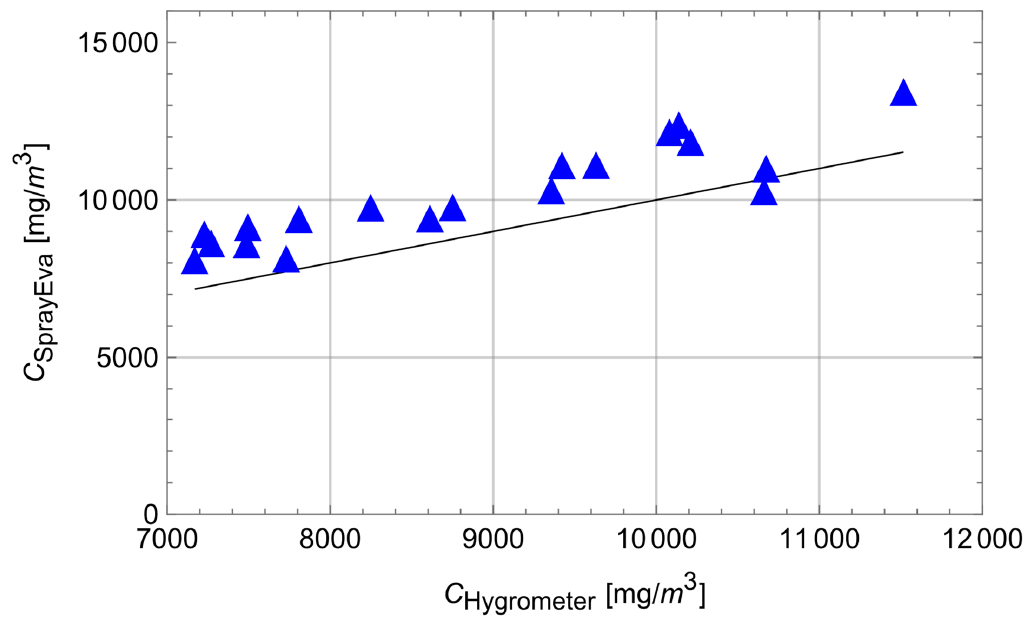
Figure 6. Measured data vs. SprayEva estimates of H 2 O-vapour exposure. Looking at the deviations between the model values and the measurement values, SprayEva tends to overestimate exposure (bias SprayEva = 0.14, rel.bias SprayEva = 15.5%). In addition, the correlation between the tool predictions of exposure and the measurement data is r SprayEva = 0.904, good but not excellent. This partial lack of agreement may be at least partly explained by the measurement limitations described above. Secondly, SprayEva does not take into account the condensation of water vapour on surfaces, which may occur in reality. Taking these limitations into account, the results are nevertheless regarded as supportive and acceptable (due to the trend of conservative estimates) for the plausibility and predictive power of SprayEva. Finally, it has to be noted that the simulation results presented in Table 4 were calculated using temporal resolutions Δ t in the range between 0.01 and 0.05 s for the spraying phase and 2 s for the post-spraying phase. The integer multiple IM for Δ t was set to 20, that is, the spatial resolution and the calculation time were reduced by a factor of 20, which proved to be a good compromise between accuracy and computation time. 4. Discussion Due to the complex relationships between substance properties, process parameters, work practices, and ventilation, currently there is a lack of mathematical models to provide useful predictions of worker exposure for spraying operations, especially for the spraying of (semi)-volatile substances. That is, exposure modelling requires strong simplifications taking into account only the most influential input parameters. Since this inevitably leads to model uncertainties, there is always a trade-off between the accuracy of a model, the number and availability of the required input parameters, and the scope of application of the model. Because the availability of the input parameters is limited in the risk assessment procedure under the Biocide and REACH regulations, the main goal when developing SprayEva was to keep the model as simple as possible without losing too much predictive power and scope. For instance, we decided not to go beyond the well- mixed room model because published studies [18,33–36] and our own evaluation exercise revealed reasonable agreement with the measured data as long as room sizes were small to medium. However, exposure estimates assuming well-mixed room conditions may be